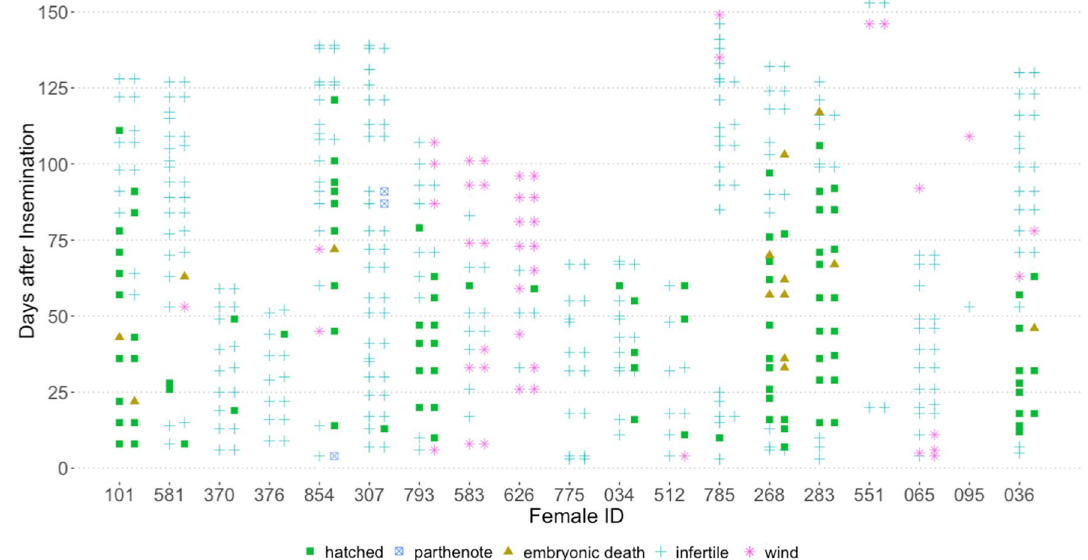
Figure 3. Oviposition dates for whitespotted bamboo shark Chiloscyllium plagiosum females after artificial insemination. Egg cases are usually laid in pairs, one egg from each side of the paired reproductive tract. Egg cases classified as fertile were assigned to categories: hatched, parthenote or embryonic death. Egg cases classified as infertile had ova without evidence of embryonic development. Empty or wind egg cases did not contain